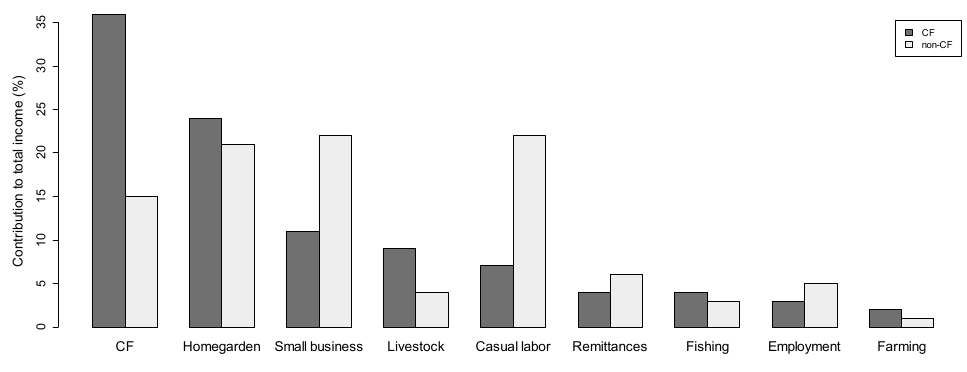
Figure 3. Income sources and shares for CF members and non-members.